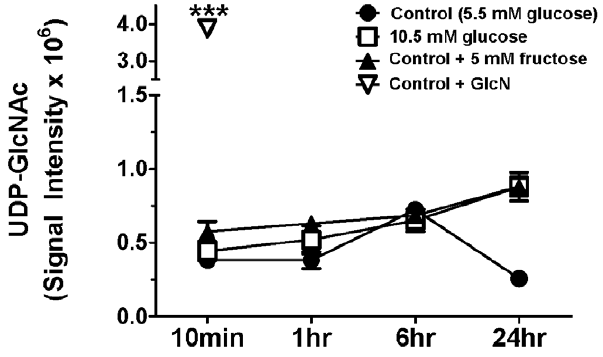
Figure 4. Concentrations of fructose metabolites in HepG2 cells incubated in the presence of glucose and fructose or glucose alone. (A) Cellular levels of fructose in HepG2 cells grown in 5.5 mM glucose (control), 10.5 mM glucose, or 5.5 mM glucose + 5 mM fructose for 48 hours before new media was added for 10 min, 1 hr, 6 hr, or 24 hr. (B) Levels of fructose-1-phosphate (F-1-P) in HepG2 cells grown in the three conditions described above. Units of intensity are quantifier ion peak heights. Means 6 SEM are depicted. ***P , 0.001 vs. controls; n=5 or 6/group.